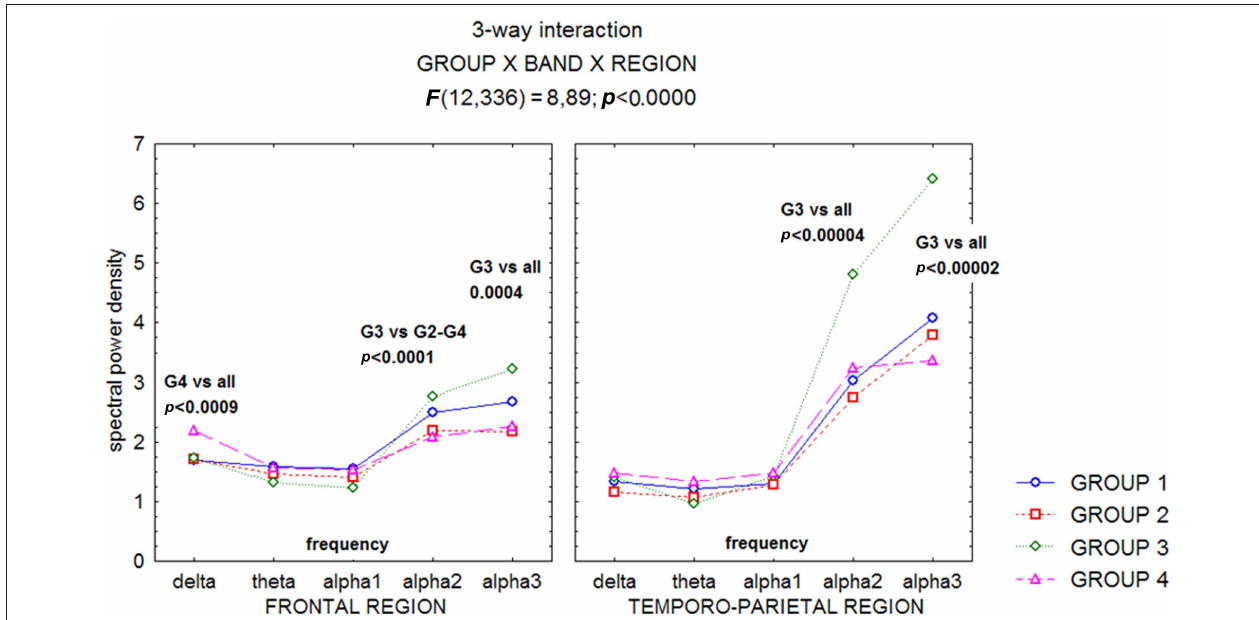
FiGurE 1 | Statistical ANOVA interaction among Group factors, and relative band powers (delta, theta, alpha1, alpha2, alpha3), on the full scalp region. The groups are based on mean and standard deviations in a normal elderly sample. Group 1, no hippocampal atrophy; Group 2, mild hippocampal atrophy; Group 3, moderate hippocampal atrophy; Group 4 severe hippocampal atrophy. Post hoc results are indicated in the diagram (see Moretti et al.,